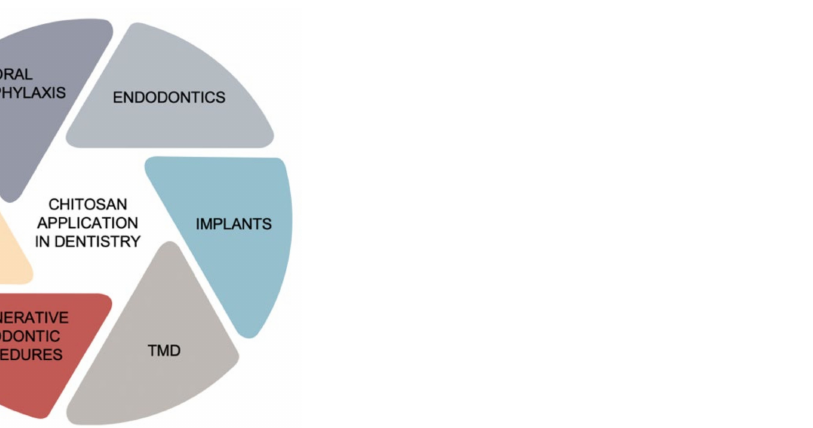
Figure 7. Application of chitosan in dentistry based on the literature [102–116]. TMDs: temporo- mandibular joint